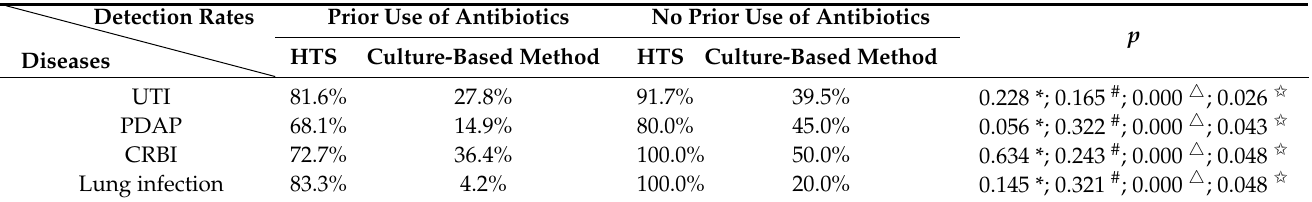
Table 4. Impacts of prior use of antibiotics on the detection efficiency of the two